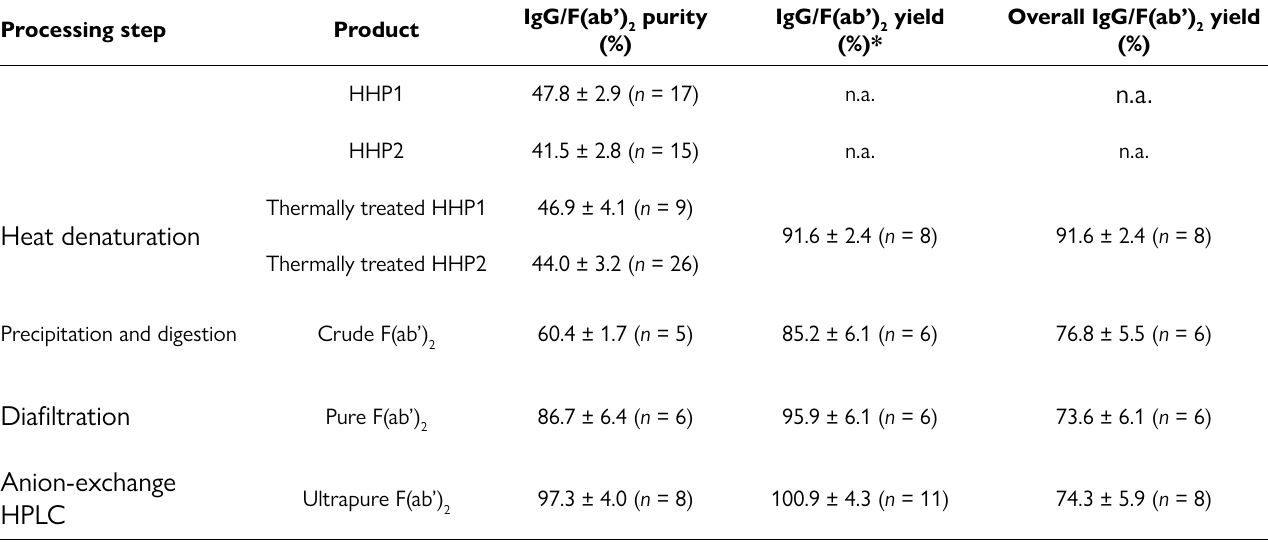
Table 1. Purities and yields of the intermediates and the final product obtained by developed downstream processing protocol. Two different plasma pools (HHP1 and HHP2) were used. IgG purities in HHPs, before and after thermal treatment, are expressed as means from n measurements +/- 95% confidence interval. IgG yields in thermally treated HHPs, as well as F(ab’) purities and yields, are given as means from n independent process performances +/- 95% 2 confidence